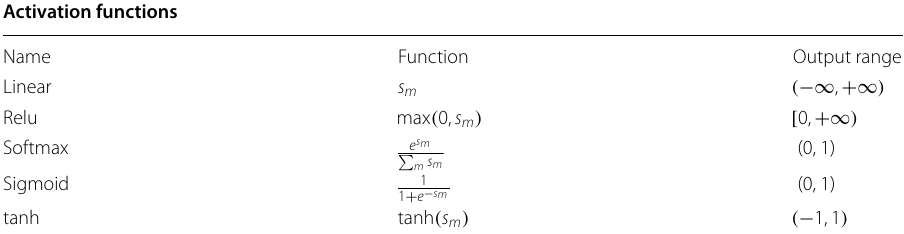
Table 3 List of activation functions used in the AE layers Activation